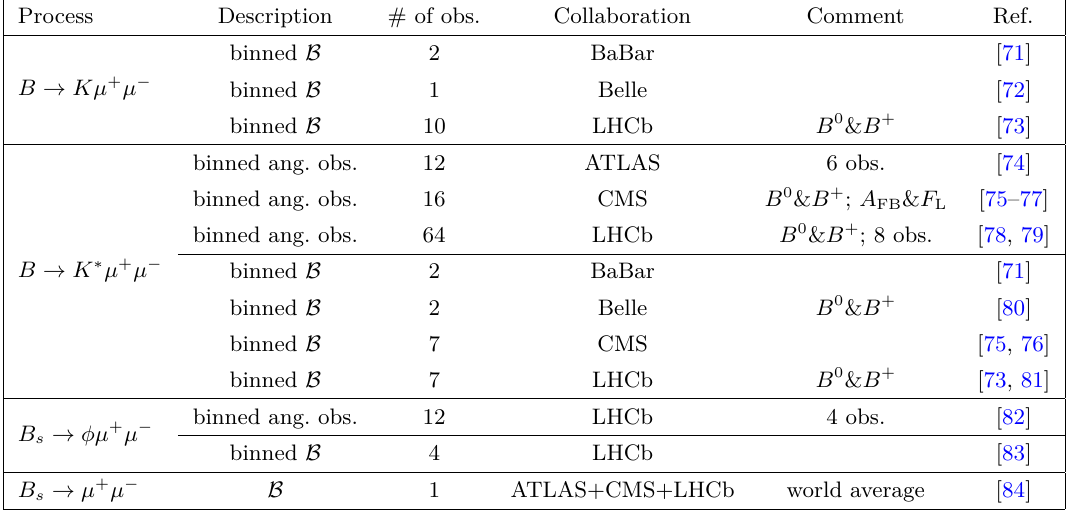
Table 4 . Summary of the experimental likelihoods used in our analysis. Binned branching ratios ( B ) and angular observables (ang. obs.) are binned in the squared dimuon invariant mass q 2 . The measurements cover the range from q 2 ∼ 1 GeV 2 to q 2 ’ 8 GeV. Present measurements of the angular observables below ∼ 1 GeV 2 suffer from inconsistent treatment of muon mass effects, and are not used here. Bins above ’ 8 GeV 2 and below the J/ψ pole are presently not available. For the B s → φµ + µ − angular analysis of ref. [82], we marginalized the likelihood w.r.t. the CP-violating observables A , which are not relevant to our analysis. i